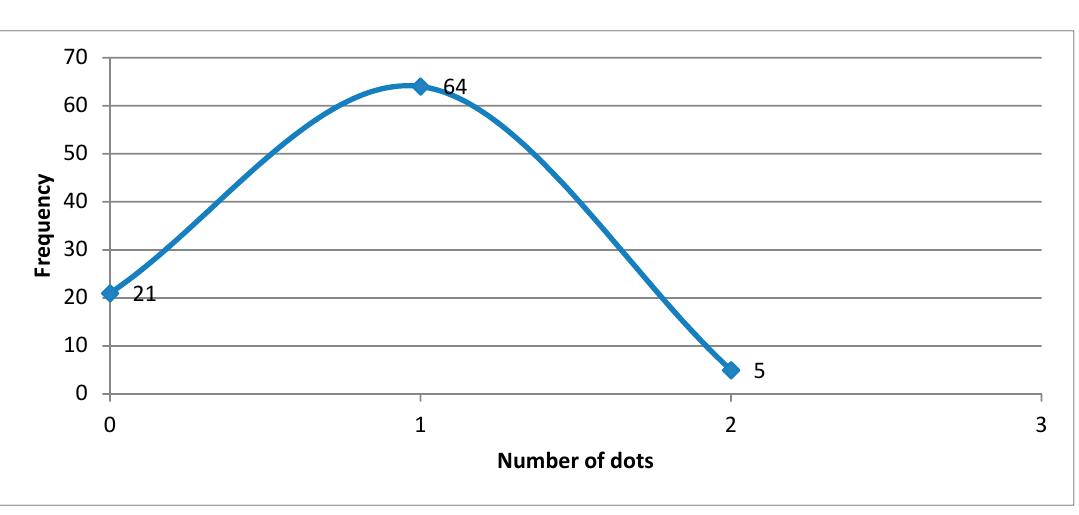
Figure 5. Degree distribution of NZBM. Source: Author